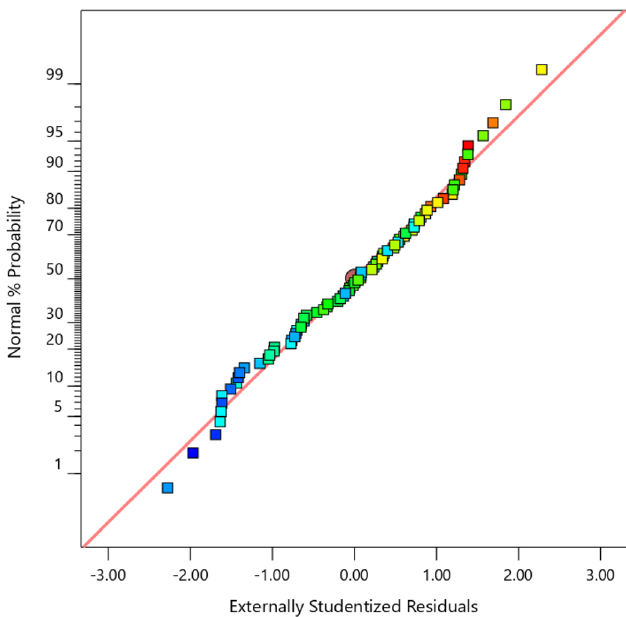
Fig. 7. Normal probability plot of residuals (bottom surface roughness).